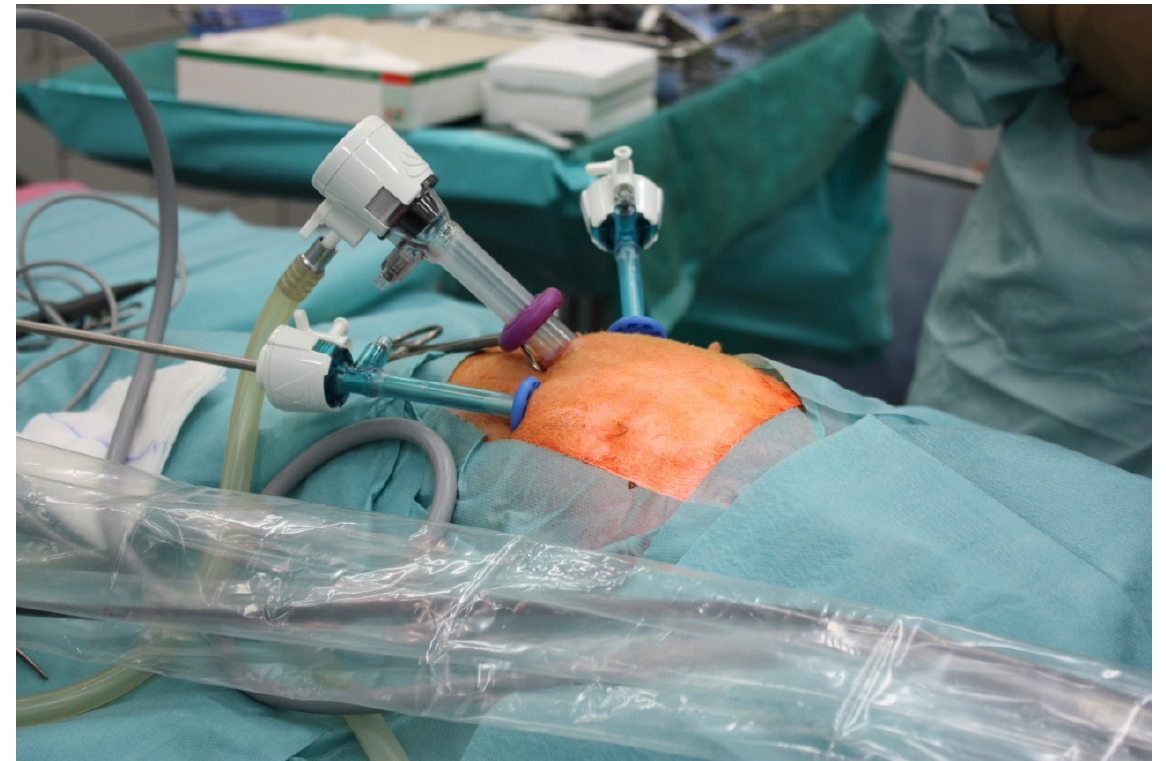
Figure 1. Laparoscopic rabbit suture set-up.